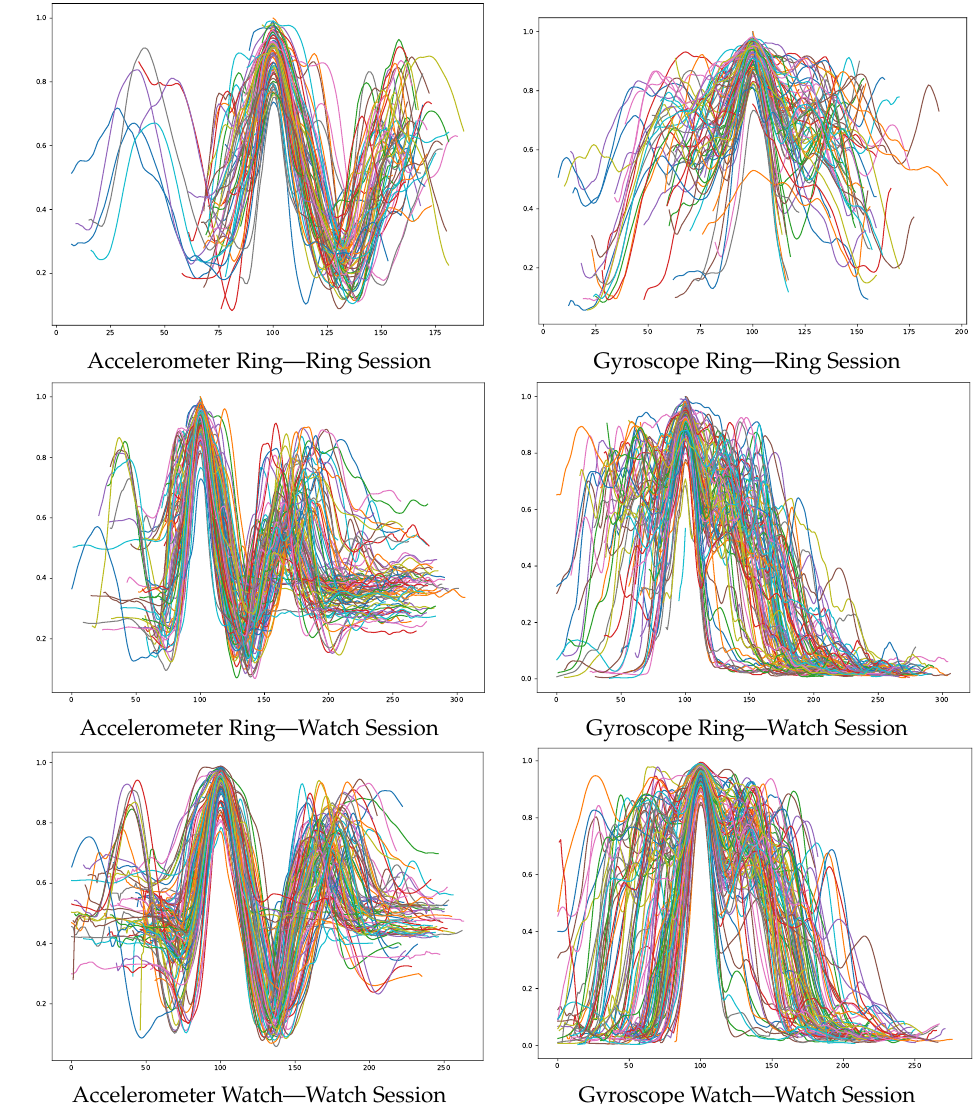
Figure 10. Preprocessed magnitude data for the Circle Clockwise gesture. The two columns contrapose accelerometer and gyroscope data and each row shows data originating from a different session. Every signal is scaled equally, and the outliers are removed. Additionally, the time shift is corrected, and the high frequency noise is